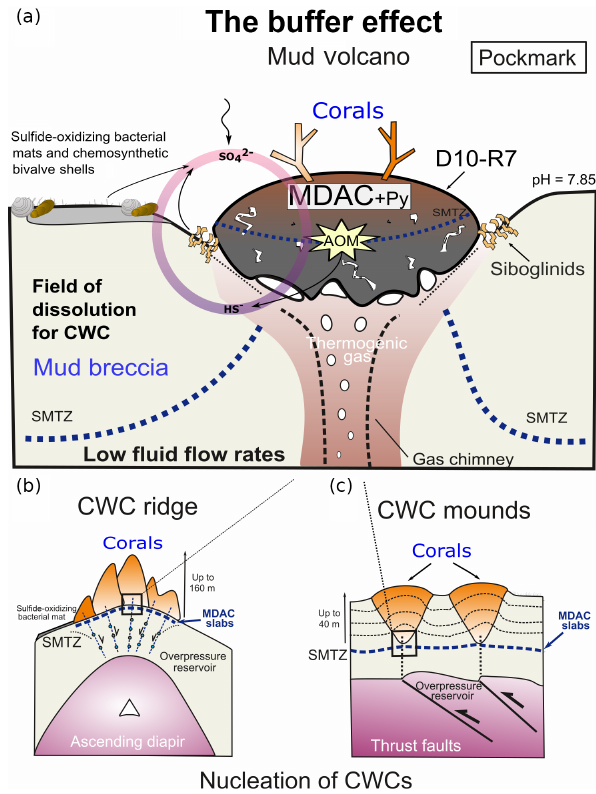
Figure 12. The buffer effect model. (a) Buffer effect at pockmark sites (e.g., sampling site of D10-R7) where carbonates are formed directly on the bubbling site acting as a cap. (b) Buffer effect at di- apiric ridges where MDAC slabs are formed on the base of the ridge. (c) Buffer effect at coral mounds where MDAC slabs are formed in deeper layers of the sediment. Py is pyrite, SMTZ is the sulfur- methane transition